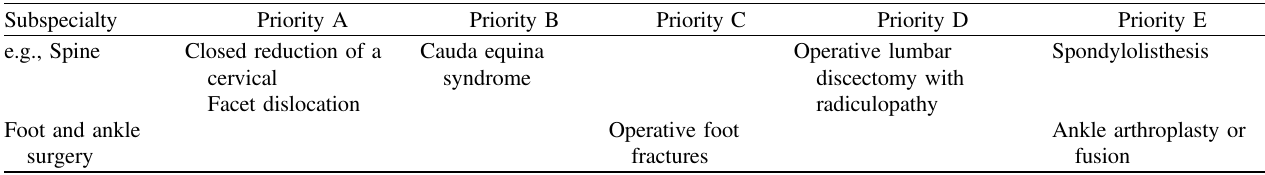
Table 1. Examples of priority strati fi cation according to Massey et al. [39].